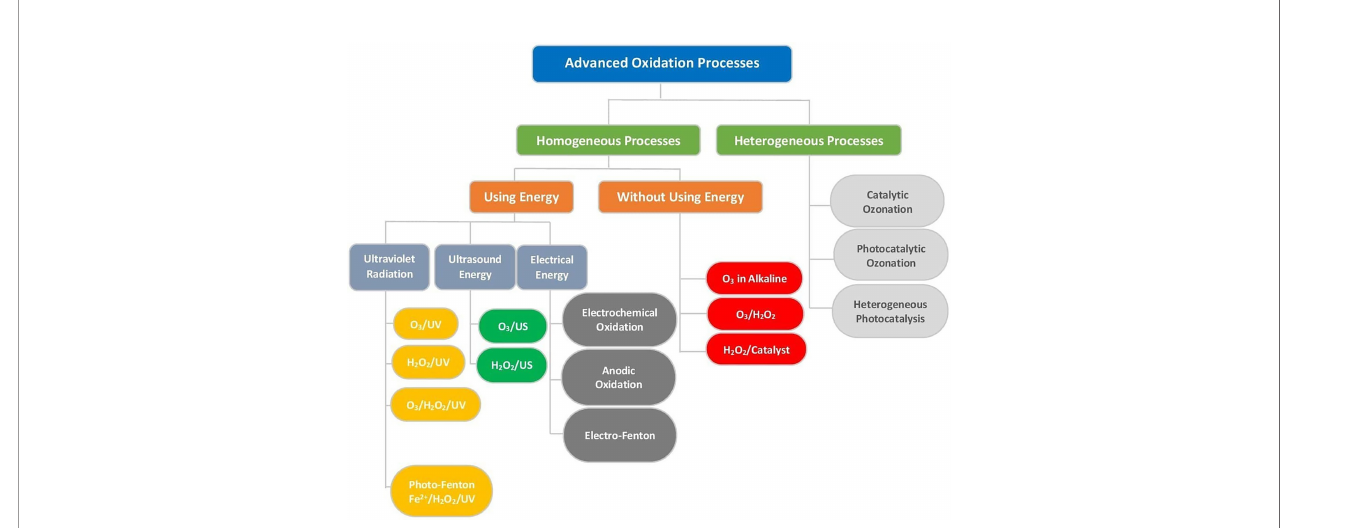
FIGURE 2 | Homogeneous and Heterogeneous Advanced Oxidation